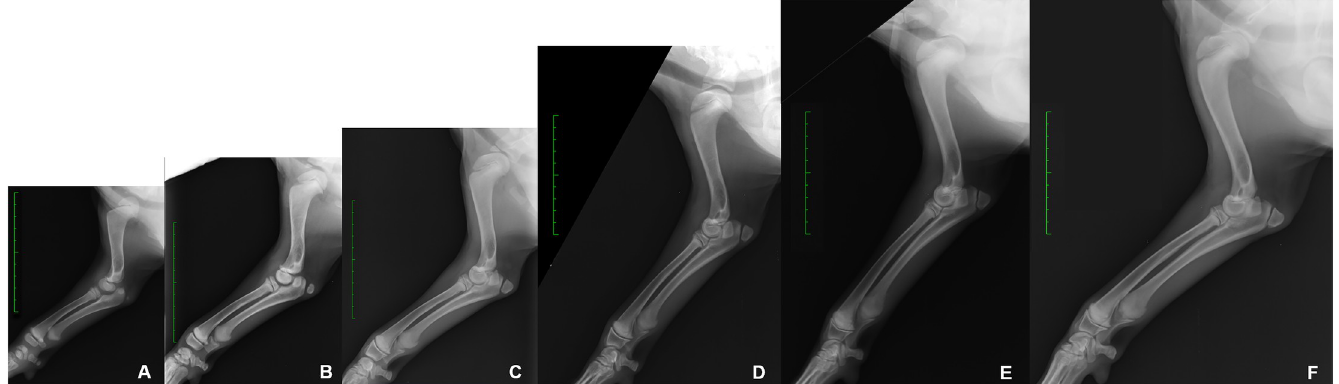
Fig 3. Representative series of radiographic images of the forelimb skeletal development. Saarloos Wolfdog, medio-lateral view of the right forelimb. A) 6 weeks of age; B) 8 weeks of age; C) 10 weeks of age; D) 12 weeks of age; E) 14 weeks of age; F) 16 weeks of age. Green scale bar: Distance between two hyphen is of 1 cm.